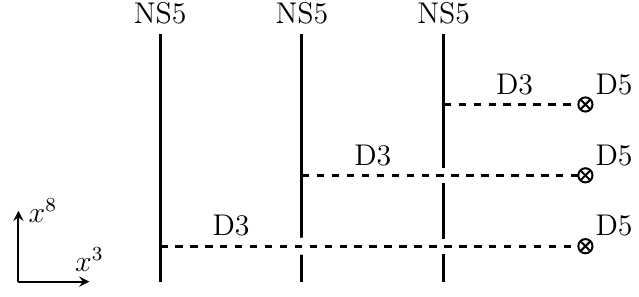
Figure 3 . The brane setup giving rise to the 3 d T [SU(3)] gauge theory. The NS5 and D5 branes are perpendicular in all non-spacetime